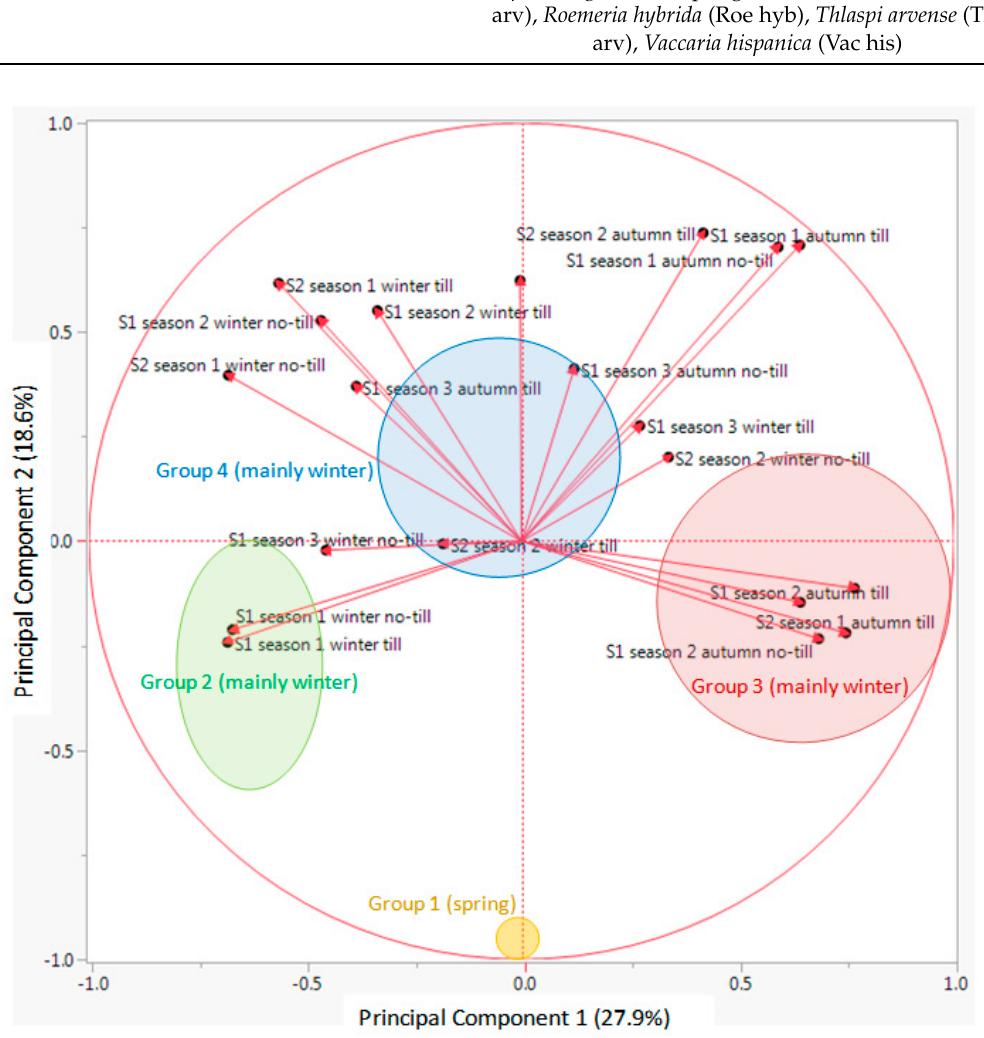
Figure 5. Biplot representation of the variables (vectors) used in a PCA of the percentage of emergence of the 30 RAP in autumn, winter or spring in two different trials under two tillage regimes. In each variable, S1 refers to the trial started in 2012, S2 for the trial started in 2013; season 1 for 2012/2013, season 2 for 2013/2014, and season 3 for 2014/2015; autumn, winter or spring, the period from which the emergence is provided; there were two burial conditions: 1 cm burial depth without